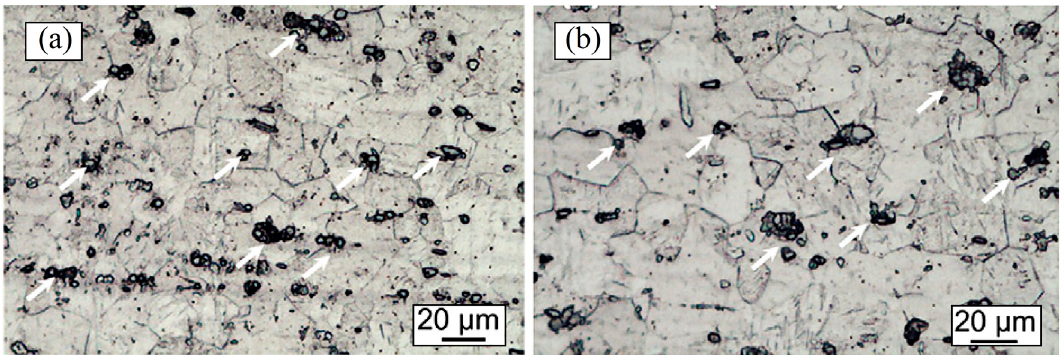
Figure 17. Optical images of Ti matrix reinforced with: ( a ) CNTs and ( b ) graphite [142]. (Adapted with permission from [142], Elsevier, 2013.)